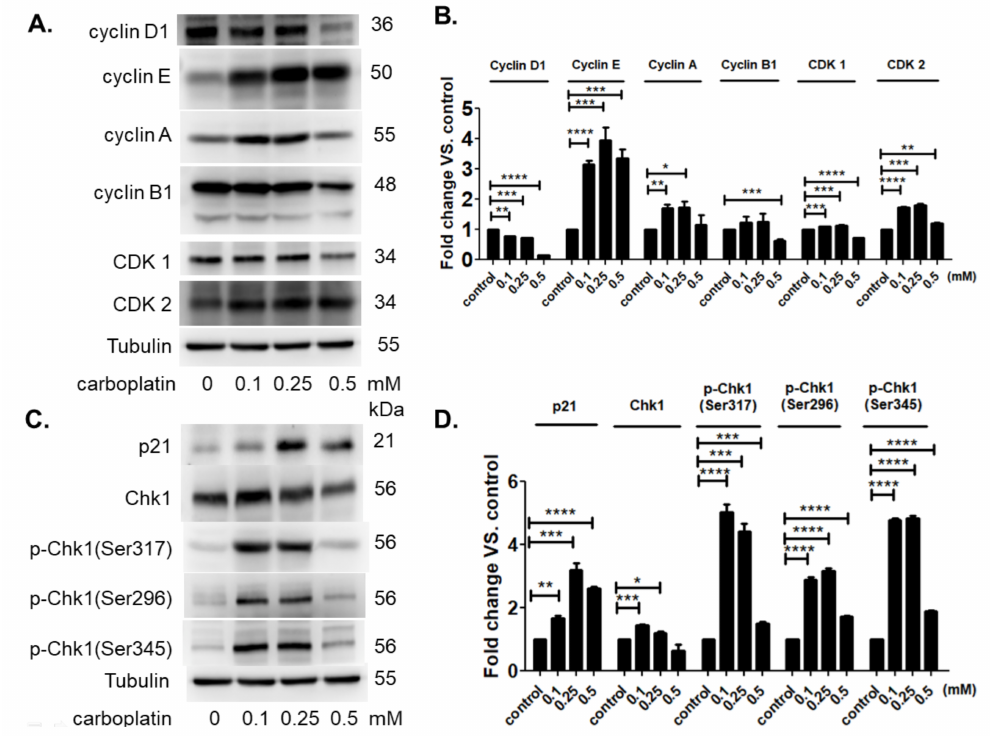
Figure 4. Carboplatin modulated the expressions of ( A , B ) cell cycle-dependent proteins and ( C , D ) cell cycle inhibitor proteins in megakaryocytic cells. MEG-01 cells were treated by carboplatin at different concentrations ranged from 0–0.5 mM for 24 h and protein expressions were then analyzed by western blot method. (* p -value < 0.05, ** p -value < 0.01, *** p -value < 0.001, **** p -value < 0.0001, three independent experiments were